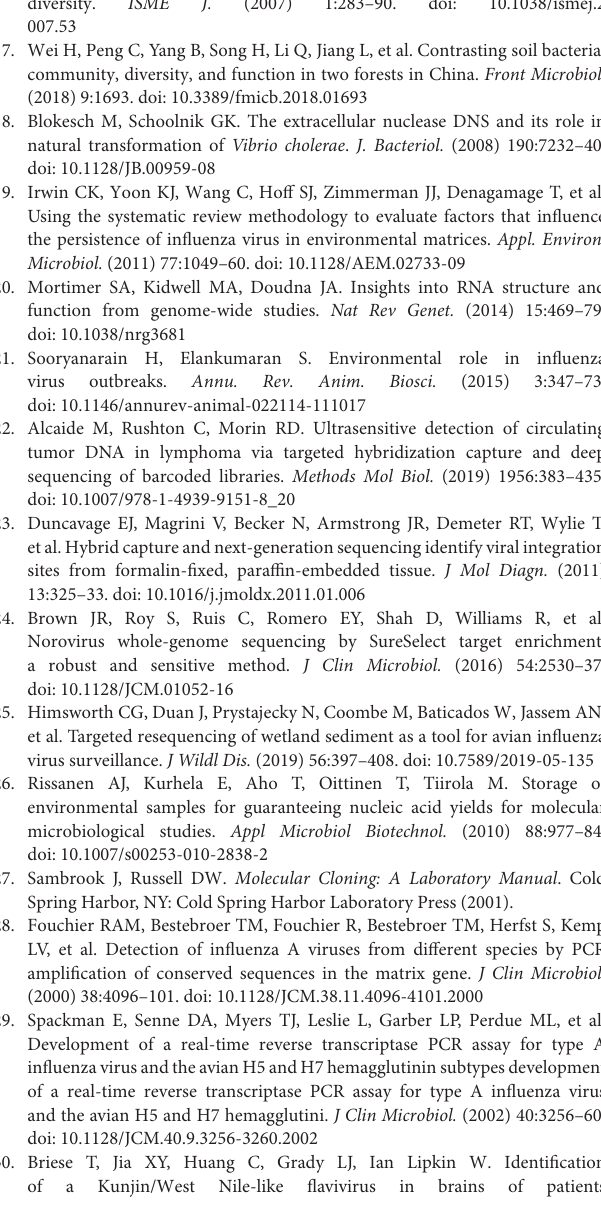
Figure S1 | Count of samples by collection date that were found to be negative, suspect positive, or positive using RT-qPCR for the MP